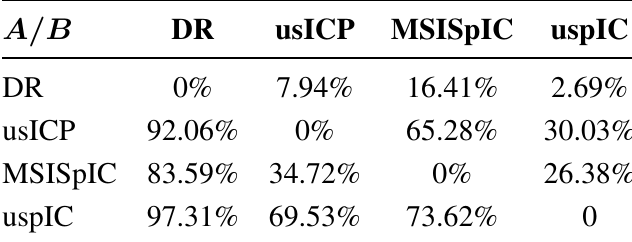
Table 1. Percentage of time where method A provided better results than method B. DR means dead